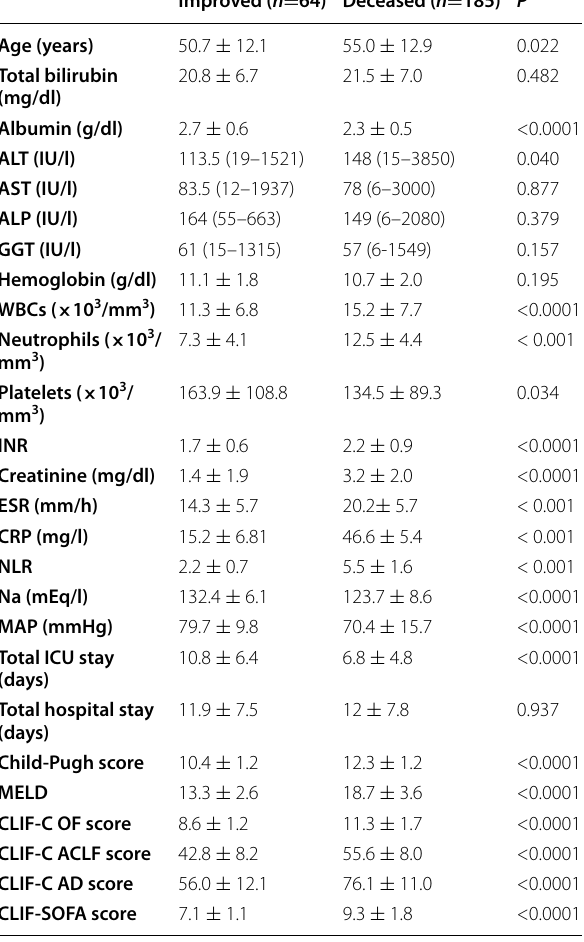
Table 4 Comparison between improved and deceased groups regarding categorical